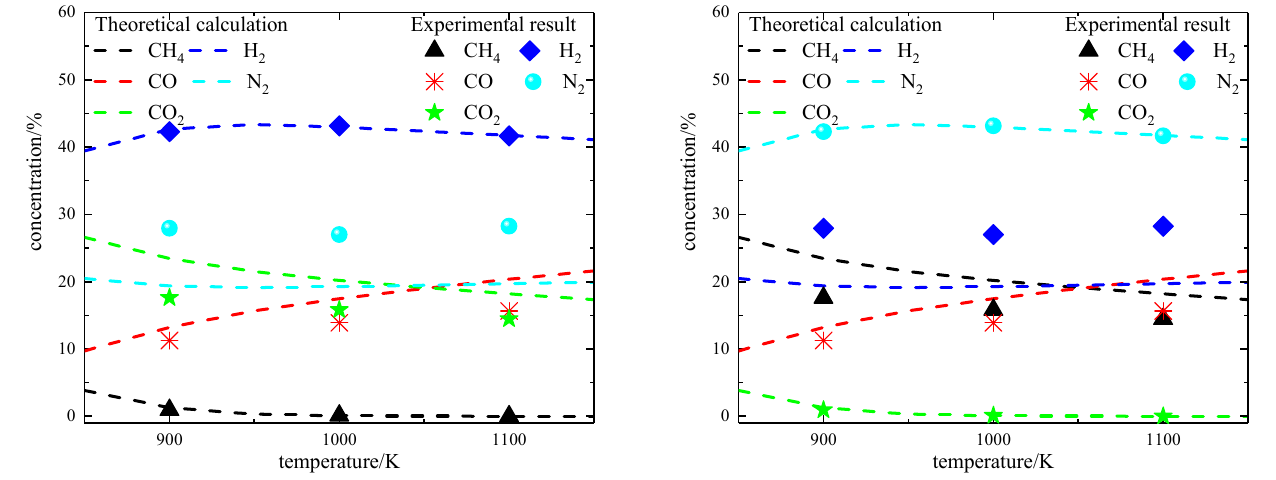
Figure 13. Comparison of theoretical calculation and experimental results.